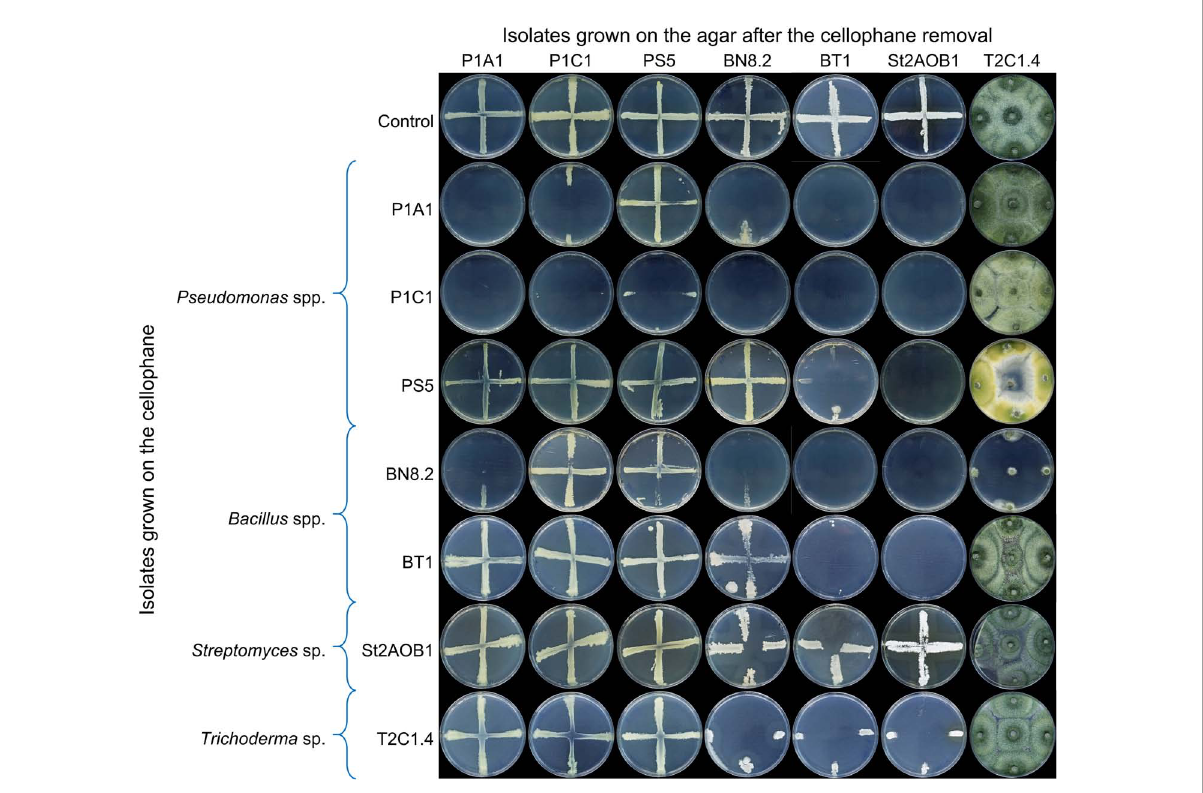
FIGURE5 Interactions amongst SynCom 1.1 isolates: effect of metabolites released in the agar medium. Cellophane-agar method (potato dextrose agar). On the rows, isolates grown on the cellophane before its removal (viz. producing putatively toxic metabolites) are indicated. On the columns, isolates inoculated in the plates after cellophane removal (viz. isolates targeted by the metabolites) are indicated. Partial growth or null growth is indicative of sensitivity to metabolites released in the medium. Each plate is representative of four replicates.